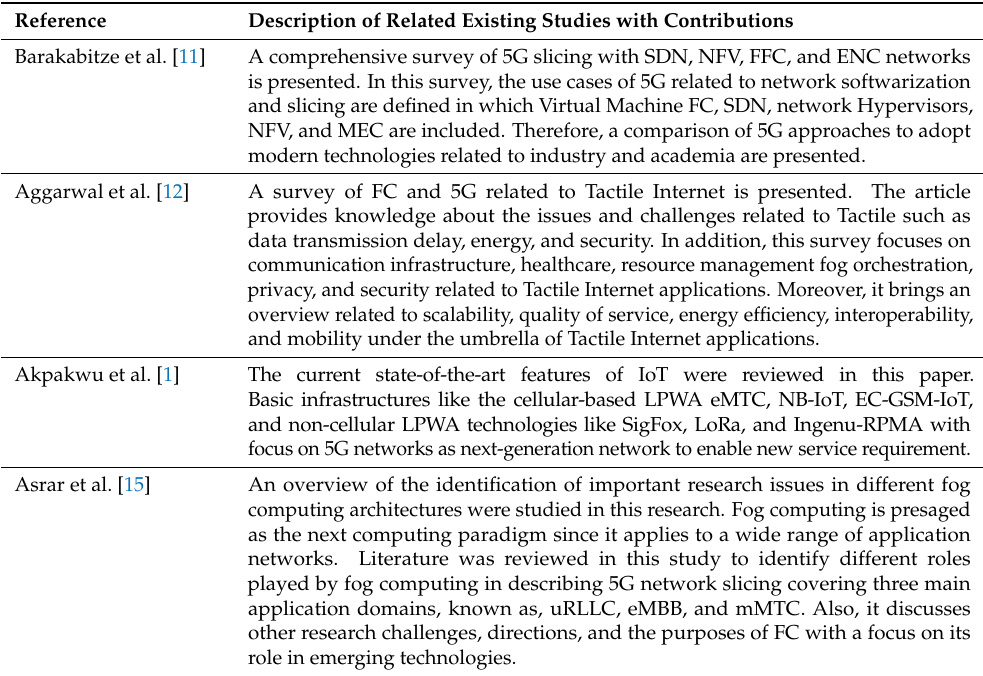
Table 1. A few of the related studies in Fog Computing as an enabler to 5G